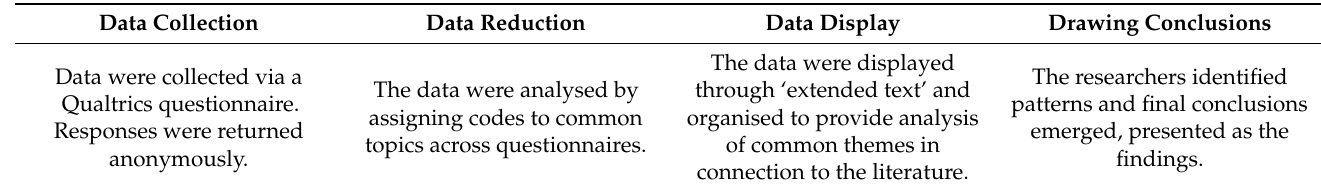
Table 1. The application of the analysis framework to the